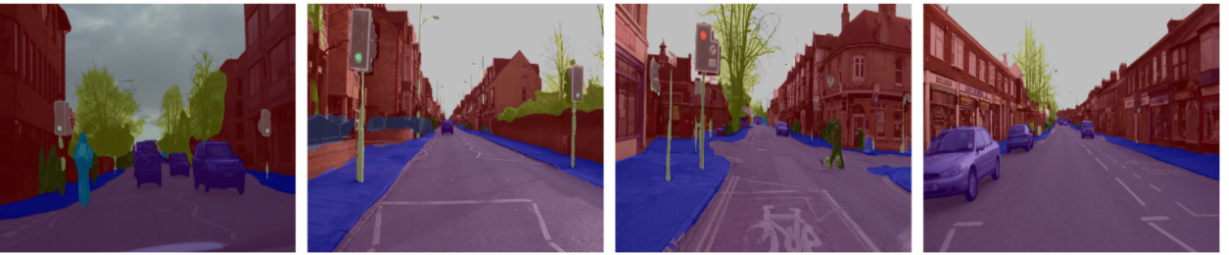
Figure 7. Segmentation results on the Camvid test